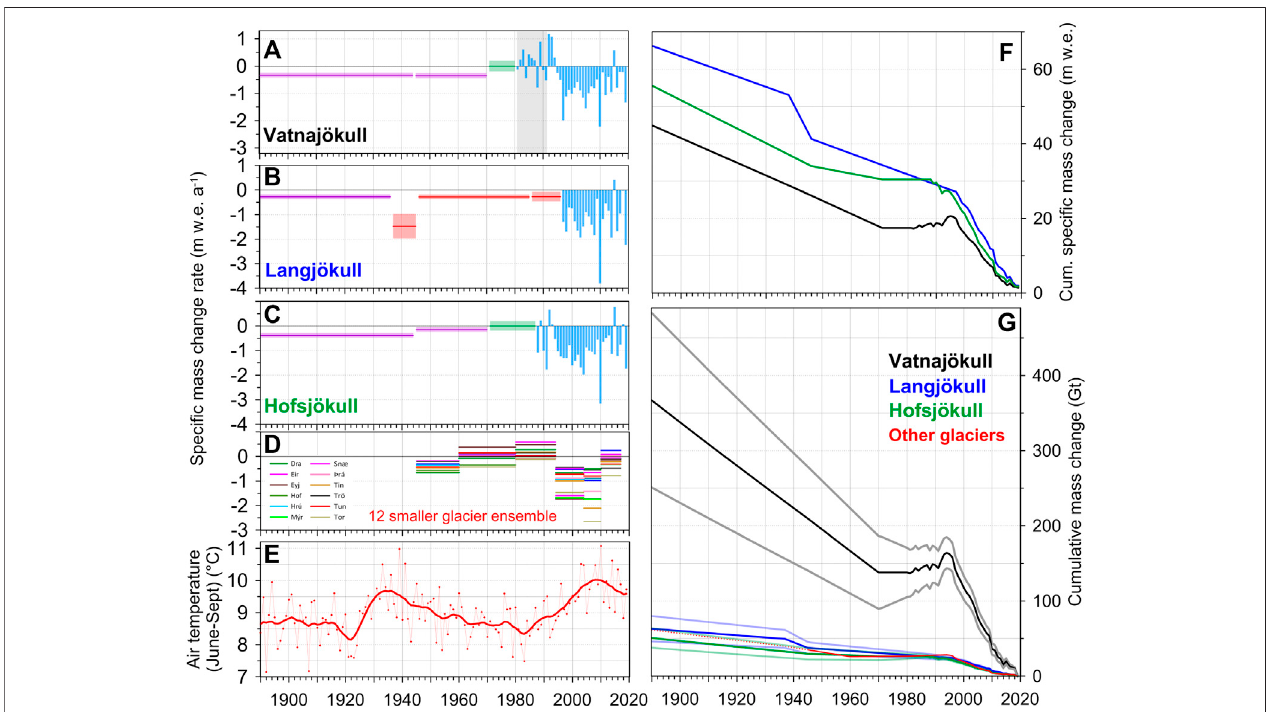
FIGURE 3 | Left: The speci fi c mass balance of glaciers in Iceland as observed, modeled, and estimated with various methods. The gray area in (A) indicates a periodofmodeledsurfacemassbalanceforVatnajökull(Schmidtetal.,2019),greenboxesin (A) and (C) areestimatesfromvarioussources(seemaintext),redboxesin (B) and lines in (D) are from geodetic mass balance (Pálsson et al., 2012; Belart et al., 2020) (heights of the boxes indicate uncertainty of measurements), and purple boxes in (A) , (B), and (C) show estimated mass loss from volume – area scaling method (see. Figure 4 ). (E) The average summer (June through September) temperature at the meteorological station in Stykkishólmur (see Figure 1 for location); the thick line shows the 11-year running average with triangular weight, a 5-year fi lter. Right: (F) Cumulative speci fi c mass balance (m w.e.) for Vatnajökull (black), Langjökull (blue), and Hofsjökull (green). (G) Cumulative mass change (Gt) of the same icecapsandthesumofotherglaciersinIcelandassumingthatthemass-balancerecordsoftheglaciersshownin (D) arerepresentativefortheunmeasuredglaciers.The red dotted line shows the extension of this record for the years 1890/91 to 1944/45 (see Section 2 ). [in (G) the mass change of Mýrdalsjökull for the years 1945/ 46 – 1959/60, not included in (Belartet al., 2020),is estimated from a linear fi t(with R 2 (cid:2) 0 . 98) between the mass balanceof Mýrdalsjökull and the average mass balance of the neighboring glaciers, Eyjafjallajökull, Torfajökull, and Tindfjallajökull, during the other fi ve periods shown in (D)